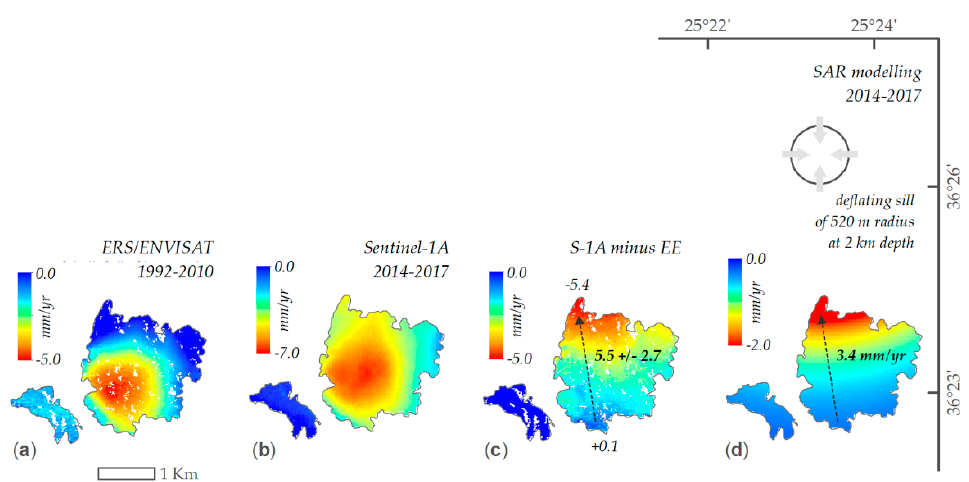
Figure 12. Vertical motion on Kameni islets derived from ( a ) ERS-ENVISAT observations for the 1992-2010 pre-unrest period [4]; ( b ) Sentinel-1 MT-InSAR observations for the 2014–17 post-unrest period; ( c ) Differences between Sentinel-1 post-unrest and ERS-ENVISAT pre-unrest motion rates; ( d ) Forward modelling results considering only the deflating 2014–17 post-unrest caldera-wide source. By compensating for the steady pre-unrest subsidence ( a ), Nea Kameni seems to undergo a tilt towards the north during the post-unrest period ( c ), fully compatible with the deformation pattern induced by the deflating caldera-wide source ( d ).